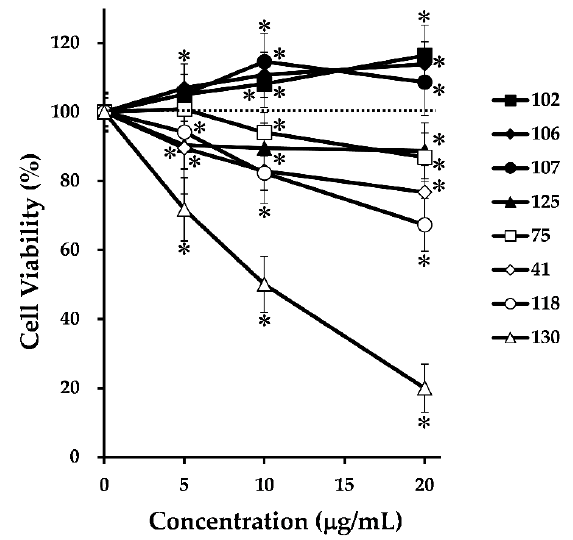
Figure 2. Effects of eight crude extracts on the proliferation of HepG2 cells. Cells were treated with each crude extract at various concentrations for 24 h, and cell viabilities were determined using MTT assay. The data represent the mean ± SD of three individual treatments using the same concentrations. ∗ p < 0.005 compared with the control group.